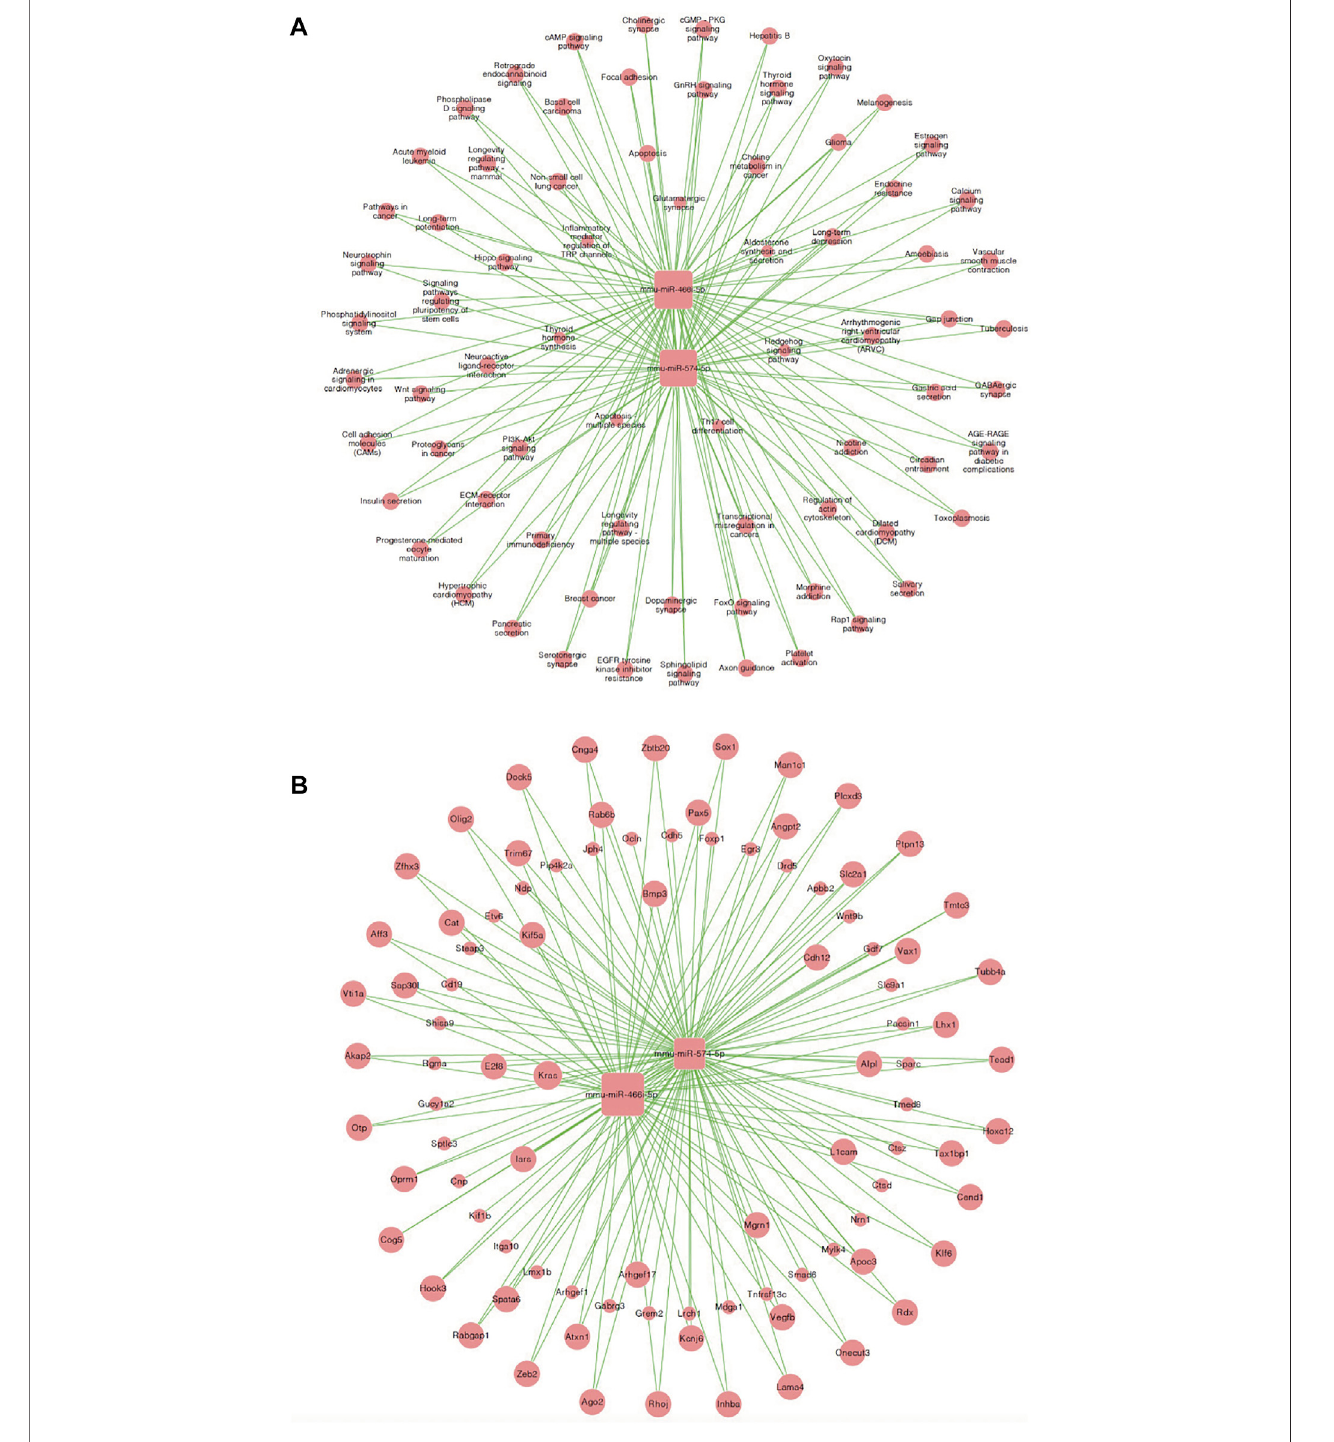
FIGURE 6 | MicroRNA-mRNA co-expression correlation network and target pathway network of core MicroRNAs. (A) MicroRNA — mRNA expression correlation network analysis of core MicroRNAs (miR-466i-5p and miR-574-5p) and their correlated mRNAs regulated by CIH post-MI. Square nodes and round nodes represent MicroRNAsand mRNAs. Thelines between nodes indicate acorrelation. Thesize ofnode representsthecorrelationstrength. (B) Networkofthe coreMicroRNAs(miR- 466i-5p and miR-574-5p) and target pathways. Square nodes represent MicroRNAs, round nodes represent pathways, and relationships between them are represented by edges. The size of node represents the correlation